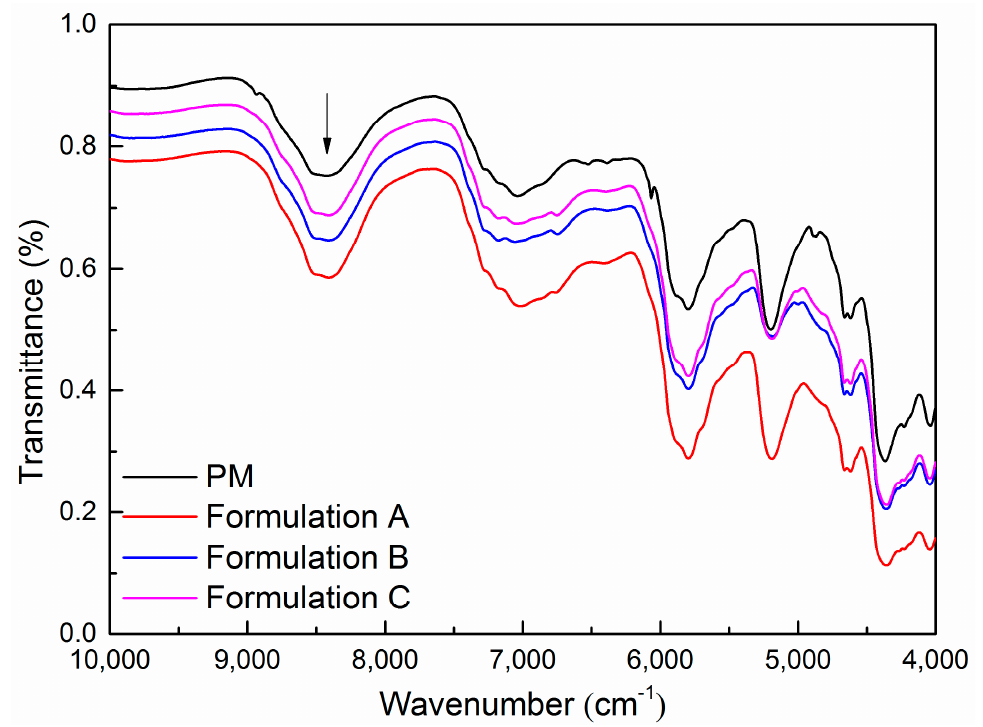
Figure 10. The NIR spectra of the physical mixtures and milled extrudates. (PM: physical mixture of ritonavir/PVPVA/Span 20).